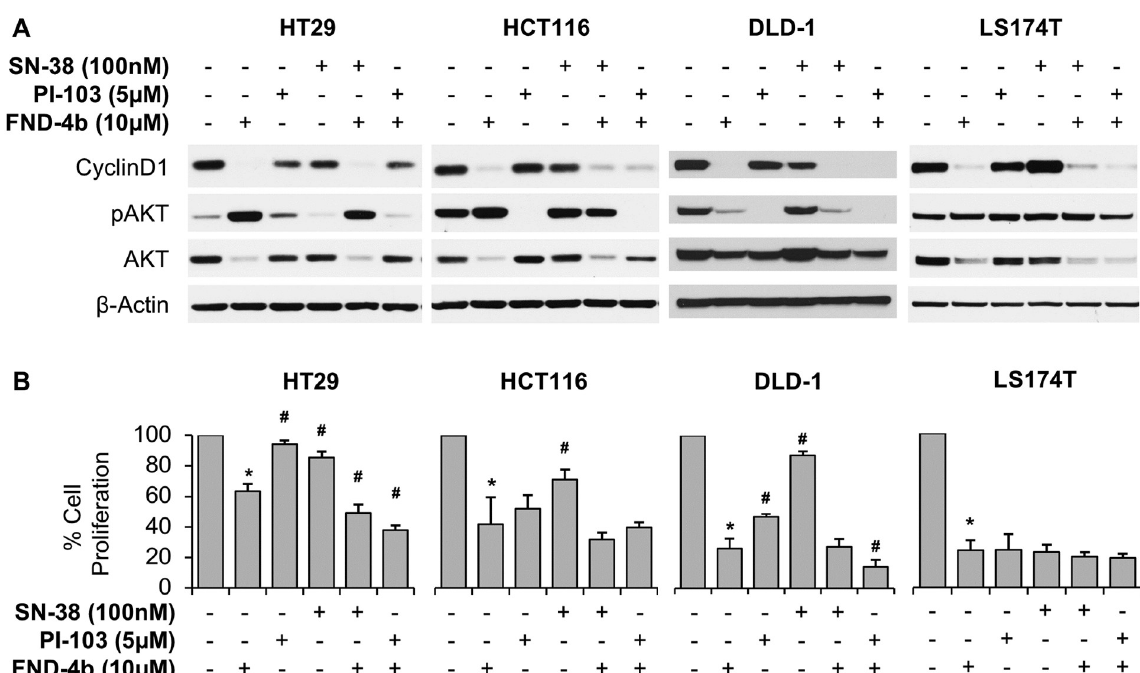
Fig 3. Cell proliferation of commercial CRC cell lines treatment combinations. (A) Western blot analysis of commercially-available CRC cell lines treated with 10 μ M FND-4b, 5 μ M PI-103, and 100nM SN-38, alone and in combination versus untreated control (media alone) for 24h duration. β -actin was used as a loading control. The images are representative of three independent experiments. In all CRC cell lines, FND-4b mono- and dual-treatment resulted in decreased cyclin D1 expression and—with the exception of DLD1—increased pAKT expression compared to untreated control. (B) SRB Cytotoxicity Assays of commercially-available CRC cell lines treated with 10 μ M FND-4b, 5 μ M PI-103, and 100nM SN-38, alone and in combination for 48h duration. Graphic representations are the mean ± SD plotted as a percentage relative to untreated control; each measurement was performed with 5 replicates. � p < 0.0001 vs. control and #p < 0.001 vs. FND-4b